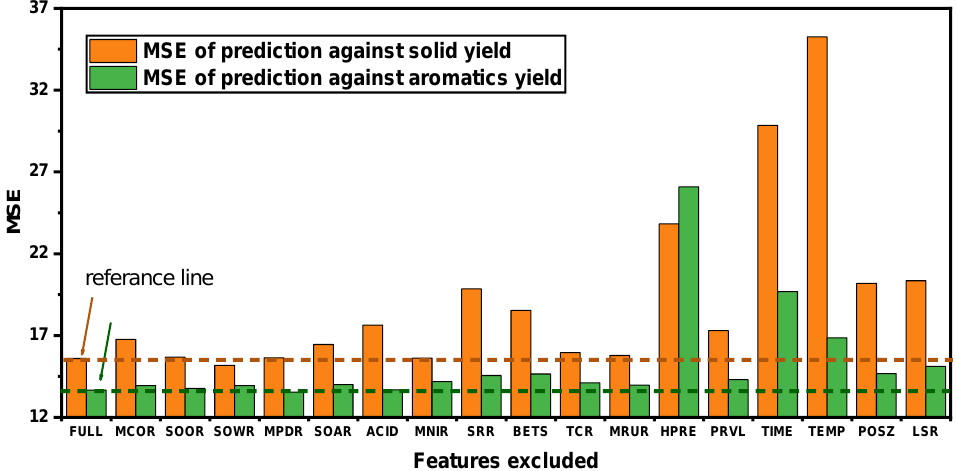
Figure 6. Comparisons of mean square error of machine leaning prediction before and after excluding each selected feature.